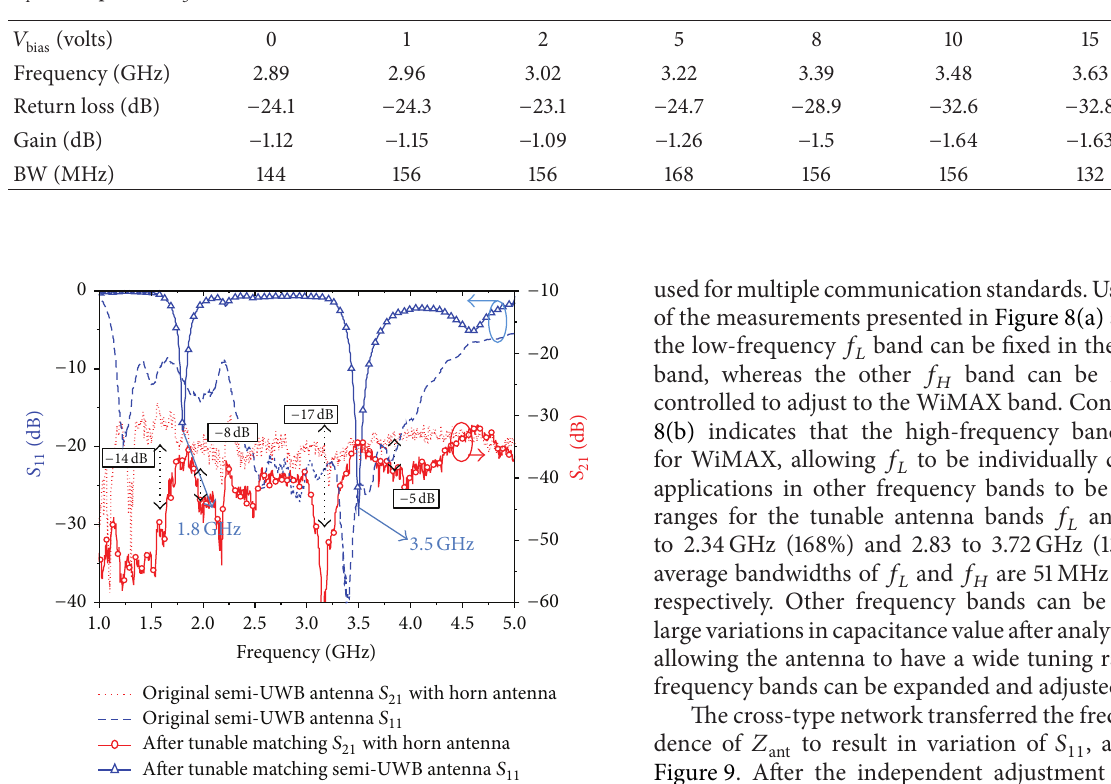
Figure 9: Wireless measurement result 𝑆 21 between a tunable dual- bandantennaandahornantenna.Thetrianglemarkedlineindicates the tunable 𝑆 11 and the dotted line is 𝑆 11 of the original broadband antenna. The circular mark line indicates the 𝑆 21 of the proposed tunable antenna and the dashed line is 𝑆 21 of the original broadband